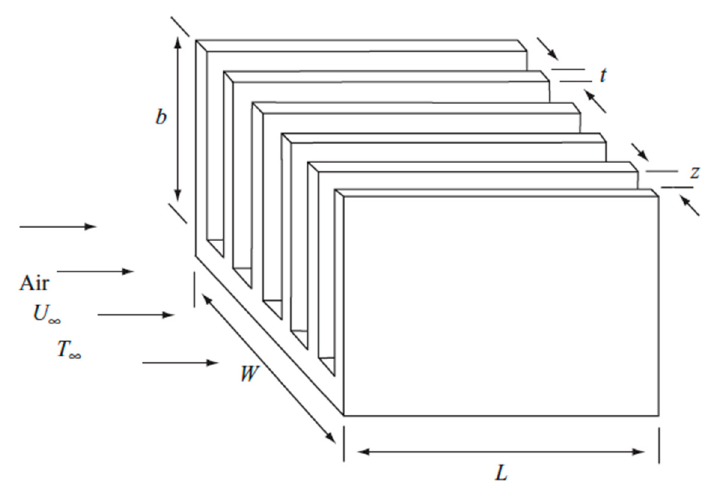
Figure 3. Forced convection multiple fin array.